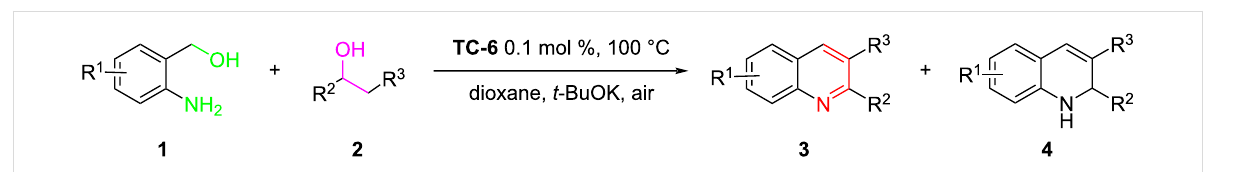
Figure 1: Some new quinoline antibacterial drugs.